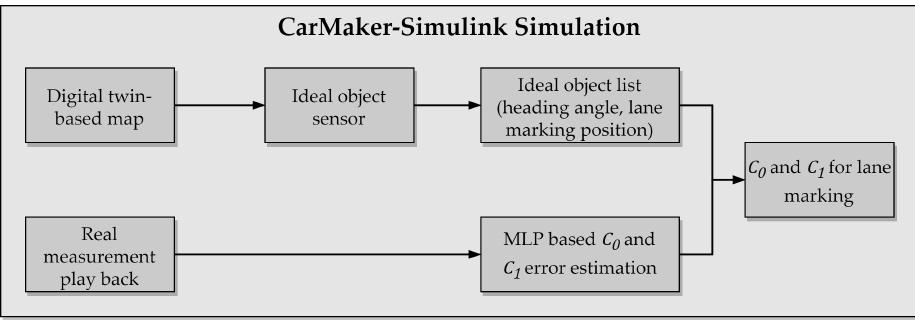
Figure 9. The procedure of the phenomenological lane detection model in